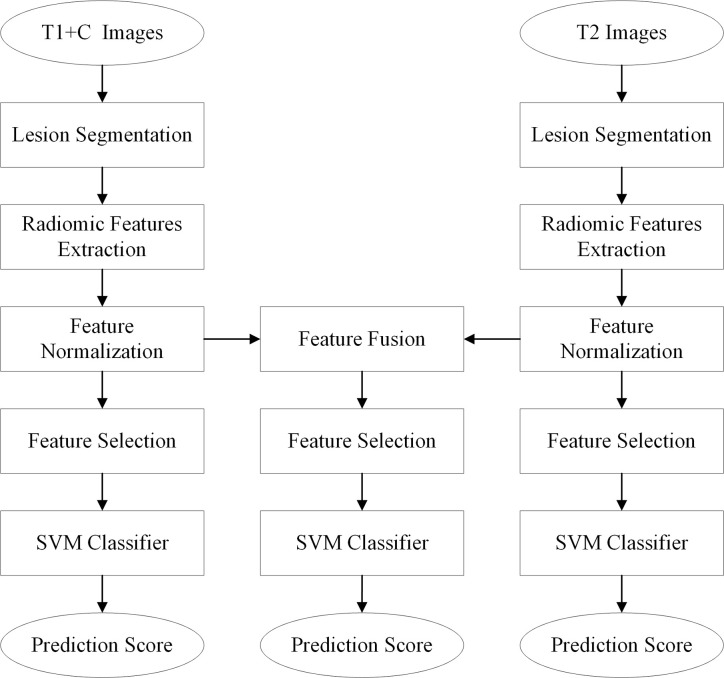
Flowchart of the proposed radiomics analysis method.